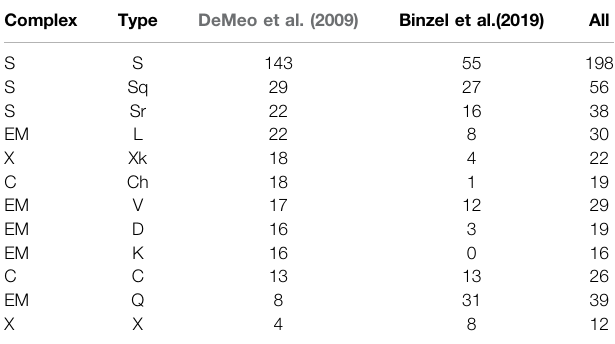
TABLE 1 | Number of objects for each taxonomic type used for classi fi cation per data